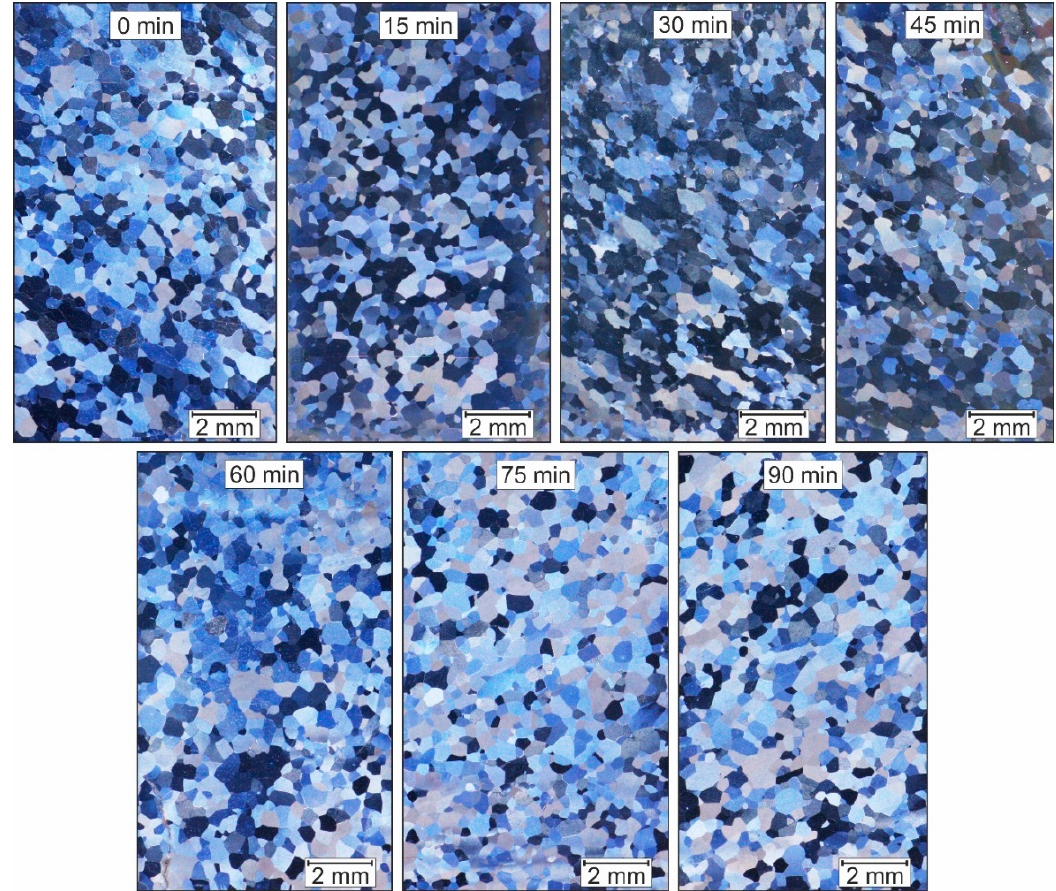
Figure 5. Fe38Al after one ECAP Pass and being heat-treated at 750 °C for different recovery times. Regardless of the duration of heat treatment after the ECAP-process, the mean grain diameters are almost identical (Table 3). This means that neither the heat treatment tem- perature nor the duration of heat conversion has an influence on grain growth or grain refinement due to static recrystallisation. Table 3. Comparison between Fe38Al formed through ECAP plus being heat-treated at 750 °C for different holding times, and the results of cast/bulk-formed Fe38Al at 1100 °C with 1 h of heat treatment (ht) [16]. Holding Time of ht in min.